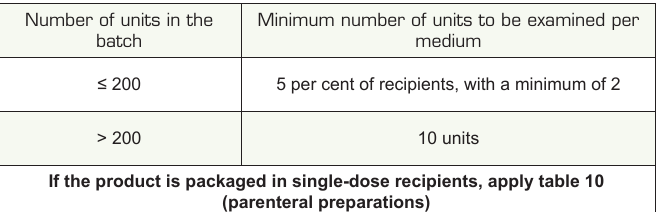
Table 11: minimum number of manufactured units to be examined for ophthalmic preparations in accordance with the European Pharmacopoeia